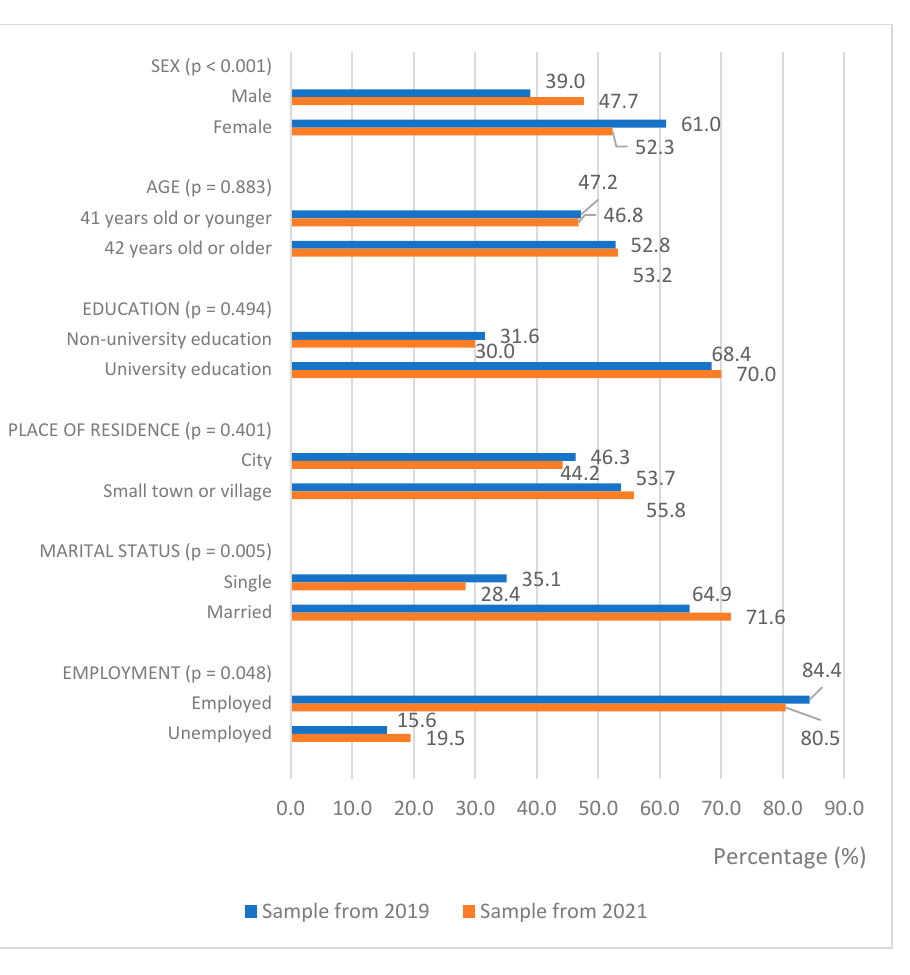
Figure 1. Distribution of the respondents who consumed dietary supplements by social and demo- graphic characteristics in both samples.